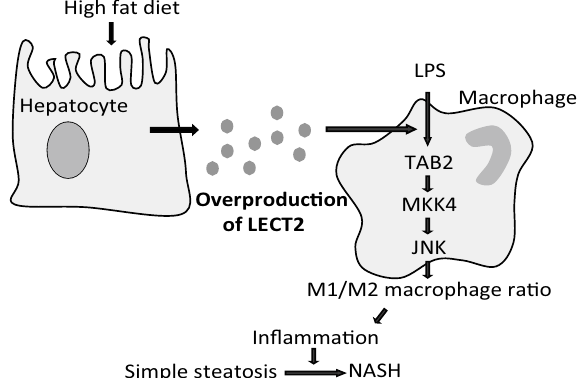
Figure 4. Proposed schema for the effects of LECT2 on liver inflammation. High-fat intake increased LECT2 protein levels in the blood and enhances LPS stimulated JNK phosphorylation which shifts liver macrophage to M1-like phenotype and causes inflammation in the